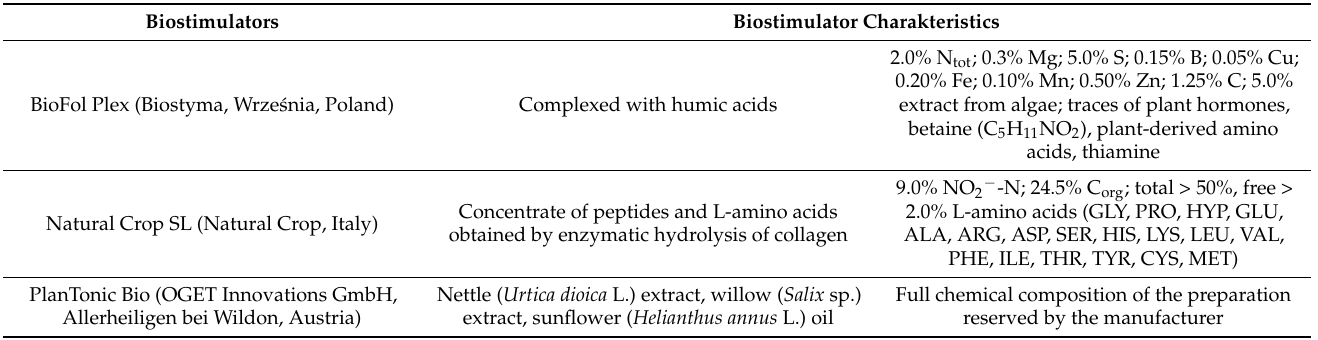
Table 2. Chemical composition of biostimulants used in the experiment.